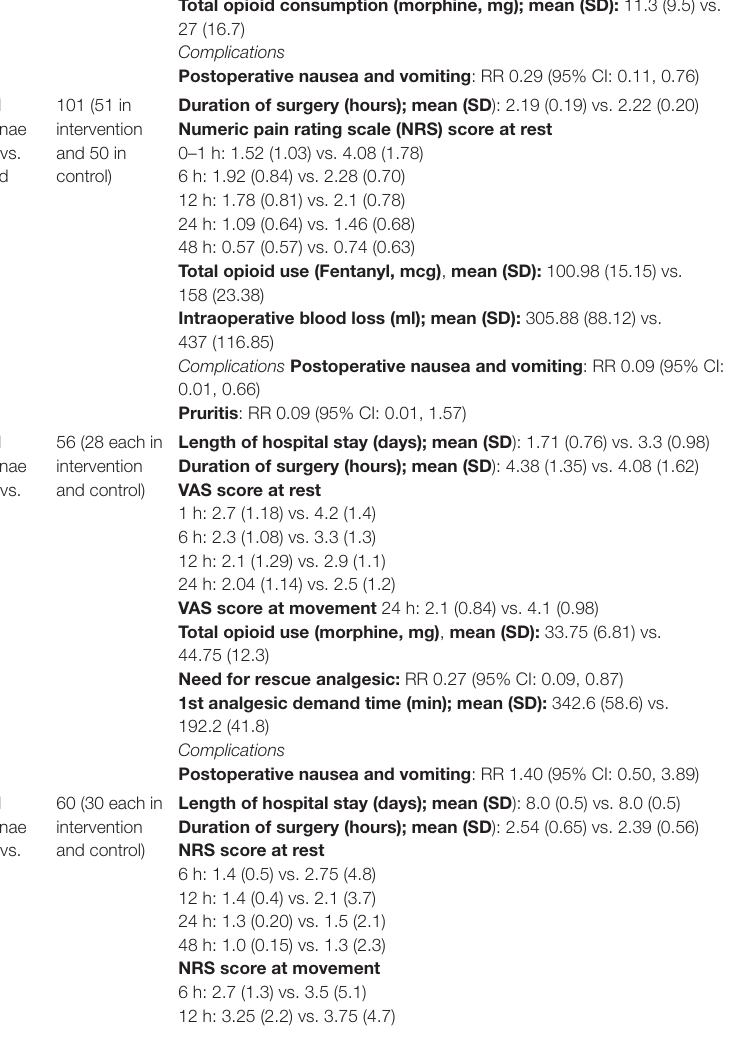
surgery; mean age of around 50 yrs; 58% female